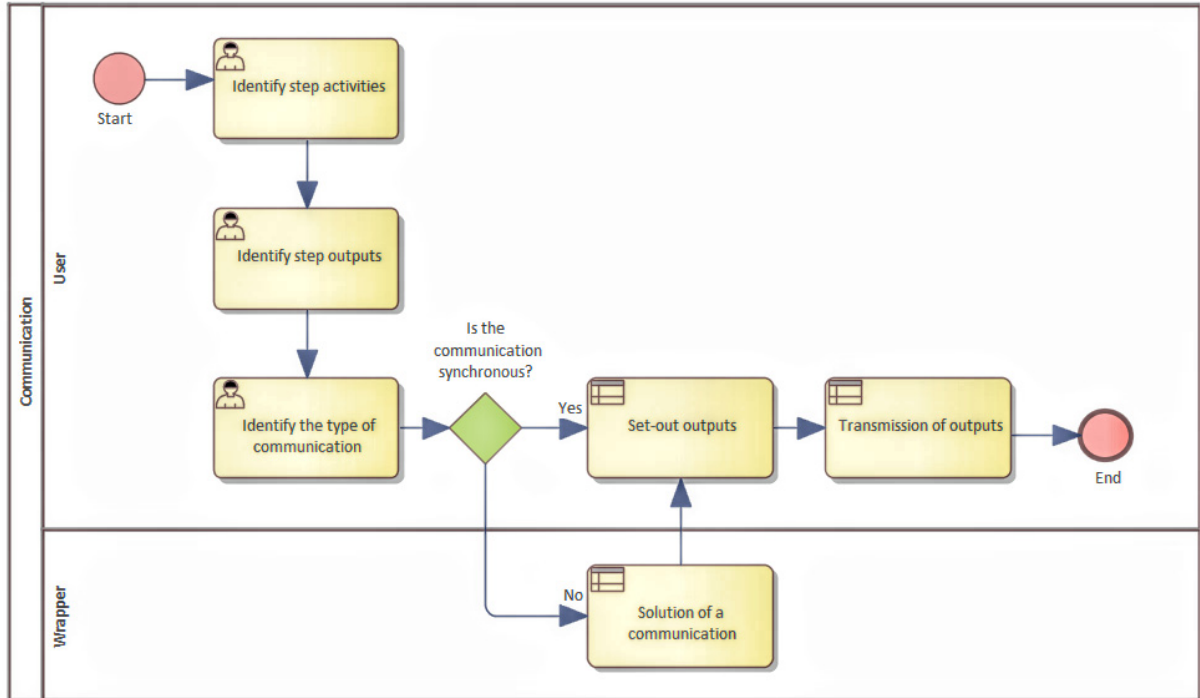
Figure 10. An identification of activities and outputs.